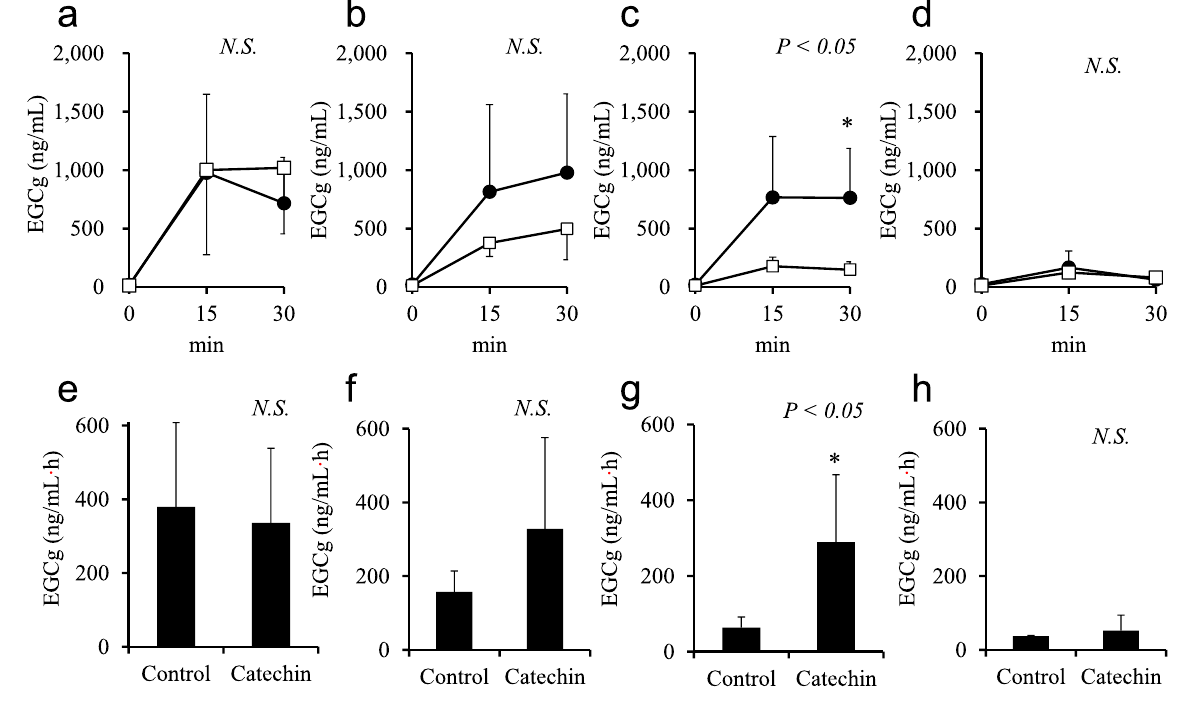
Figure 2. Plasma concentrations of epigallocatechin gallate (EGCg) after in situ catechin infusion into ( a ) the pylorus, ( b ) jejunum, ( c ) ileum, or ( d ) cecum (catechin group, ● ; control group, □ ; n = 3–6/group). Two-factor repeated measures ANOVA was used to evaluate the group-by-time interaction and the P value for this test is shown in the upper-right of each panel. The area under the curve is shown for ( e ) the pylorus, ( f ) jejunum, ( g ) ileum, and ( h ) cecum. Data are presented as mean ± SD. Significant differences as determined by Student’s t -test are indicated by * ( P < 0.05).